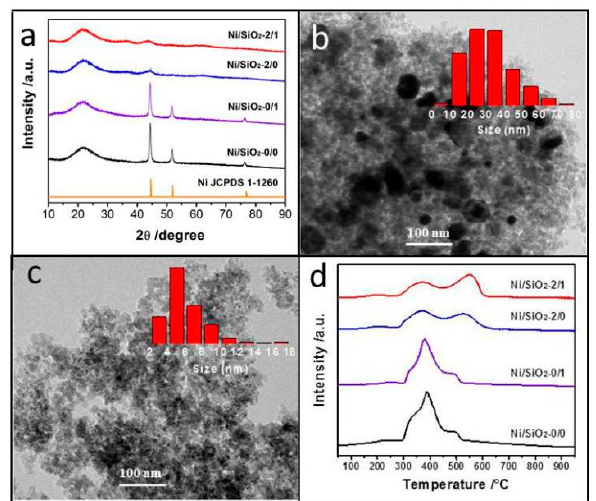
Figure 1. (a) XRD patterns of reduced Ni/SiO 2 catalysts prepared with the combustion method by using different ratios of C 2 H 5 NO 2 to NH 4 NO 3 . (b,c) TEM images and Ni size distribution of the using different ratios of C 2 H 5 NO 2 to NH 4 NO 3 . ( b , c ) TEM images and Ni size distribution of